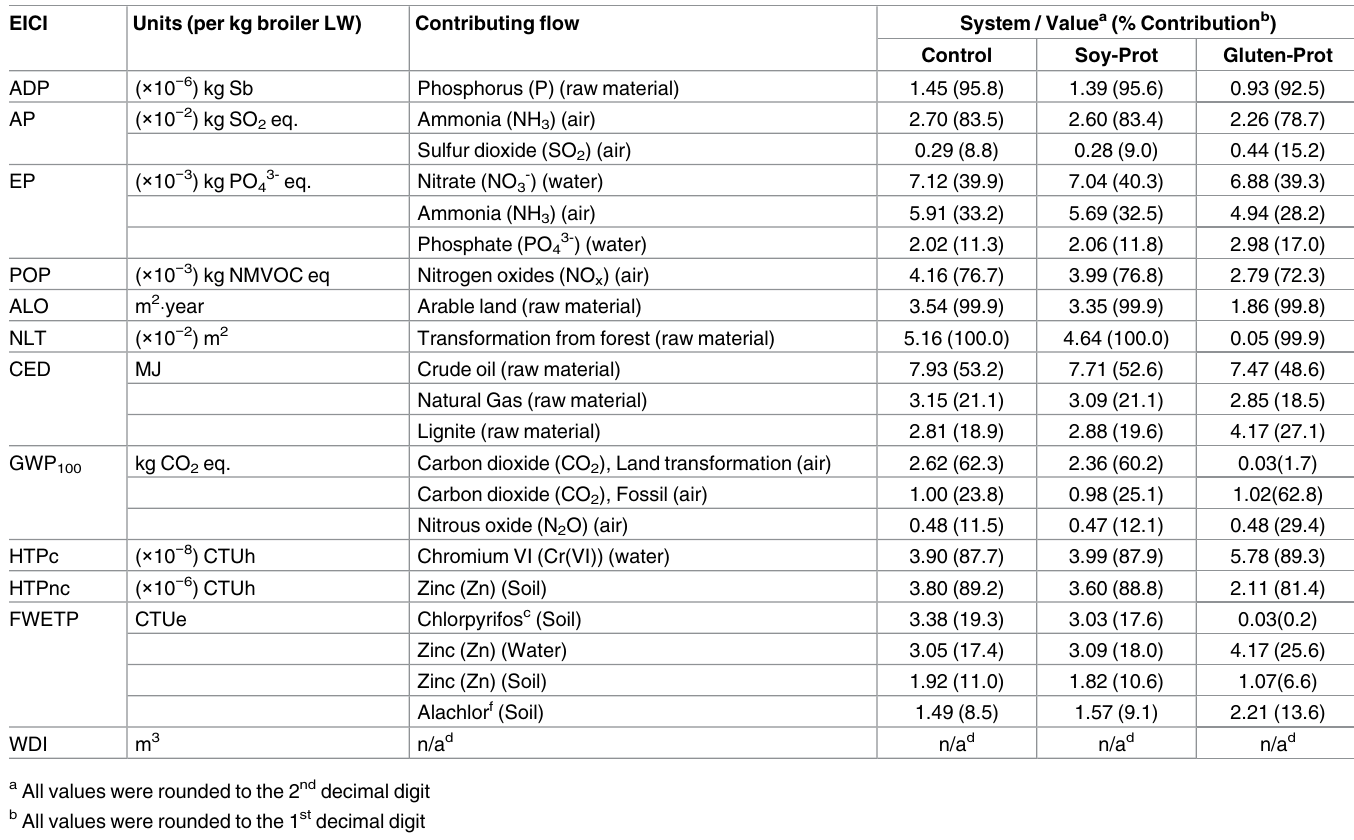
Table 11. Major contributing flows ( (cid:21) 10%contribution) and their potential contribution to the total environmental impact category indicator (EICI) values for the three systemsstudied. EICI Units (per kg broiler LW)